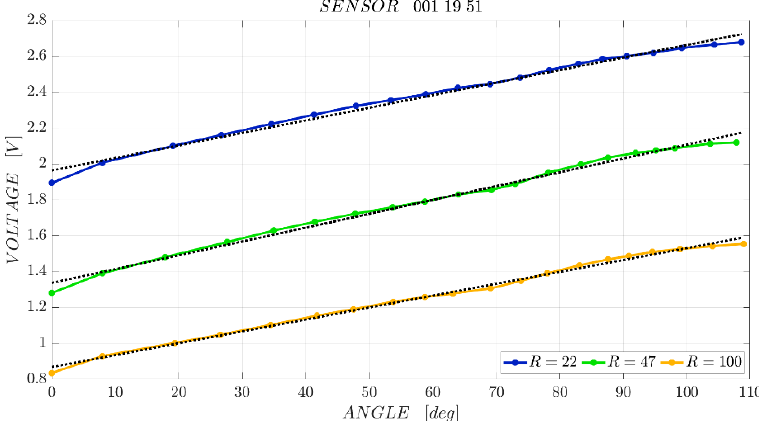
Figure 17. Analysis of resistance dimensioning: regression line of commercial